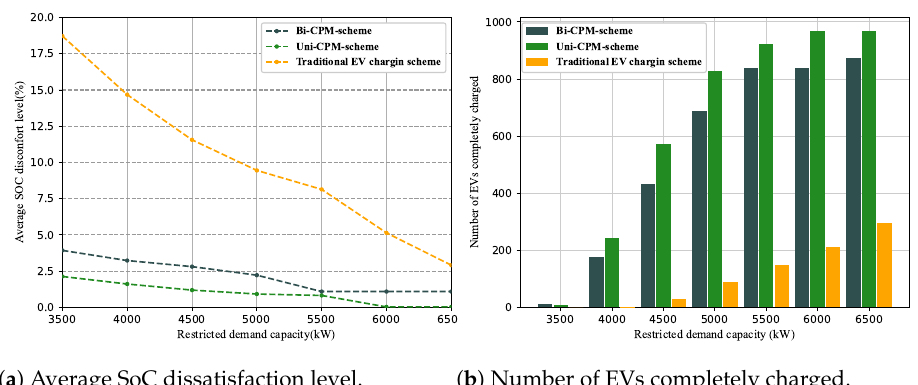
Figure 7. Analysis of average SoC dissatisfaction level and number of EVs completely charged for all 1000 EVs.